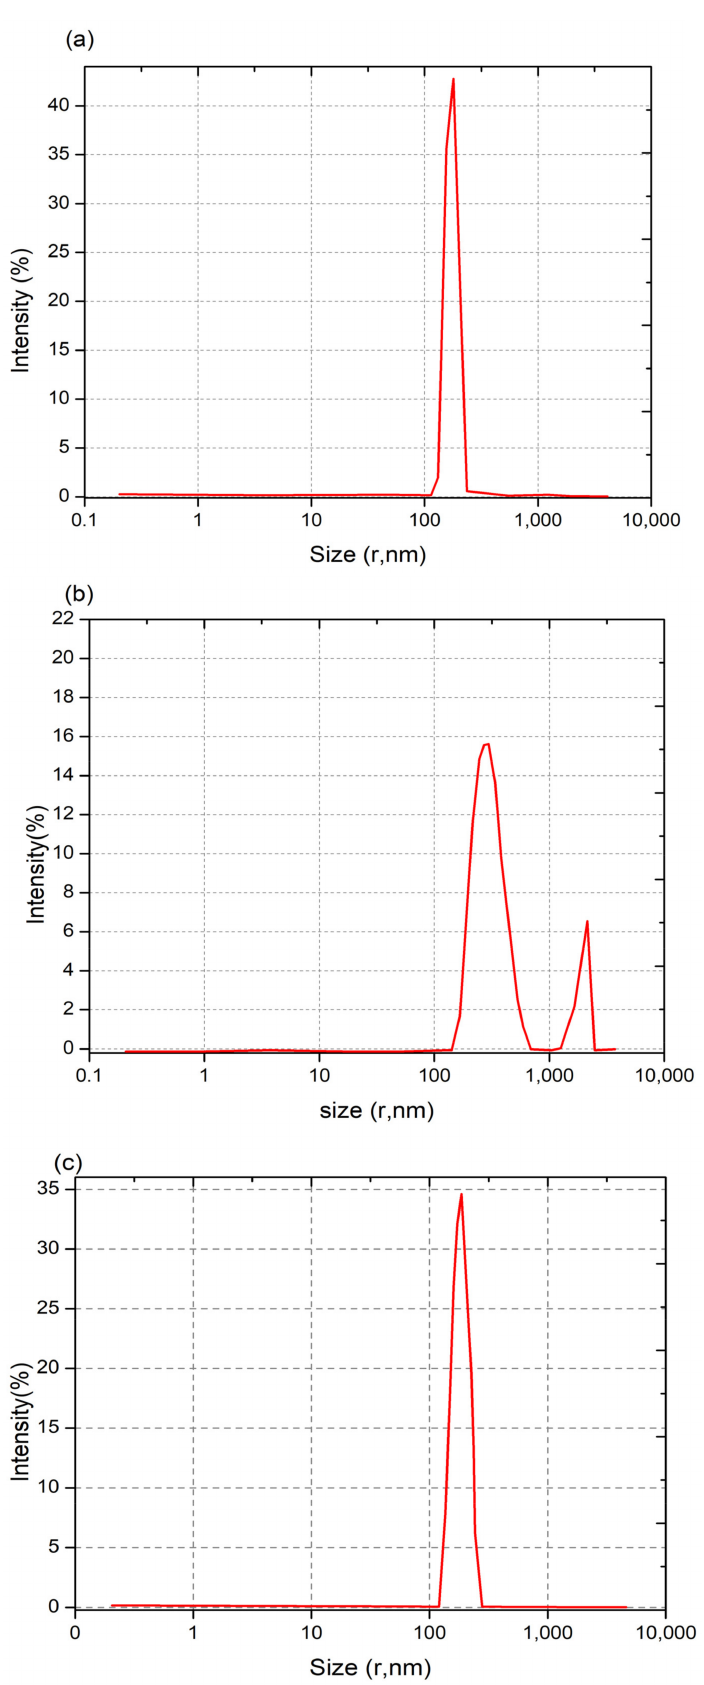
Figure 6. The size distributions as measured using DLS of ( a ) CNPs, ( b ) saponin-CNPs, and ( c ) Cu-CNP nanoparticles reproduced from Saharan et al.